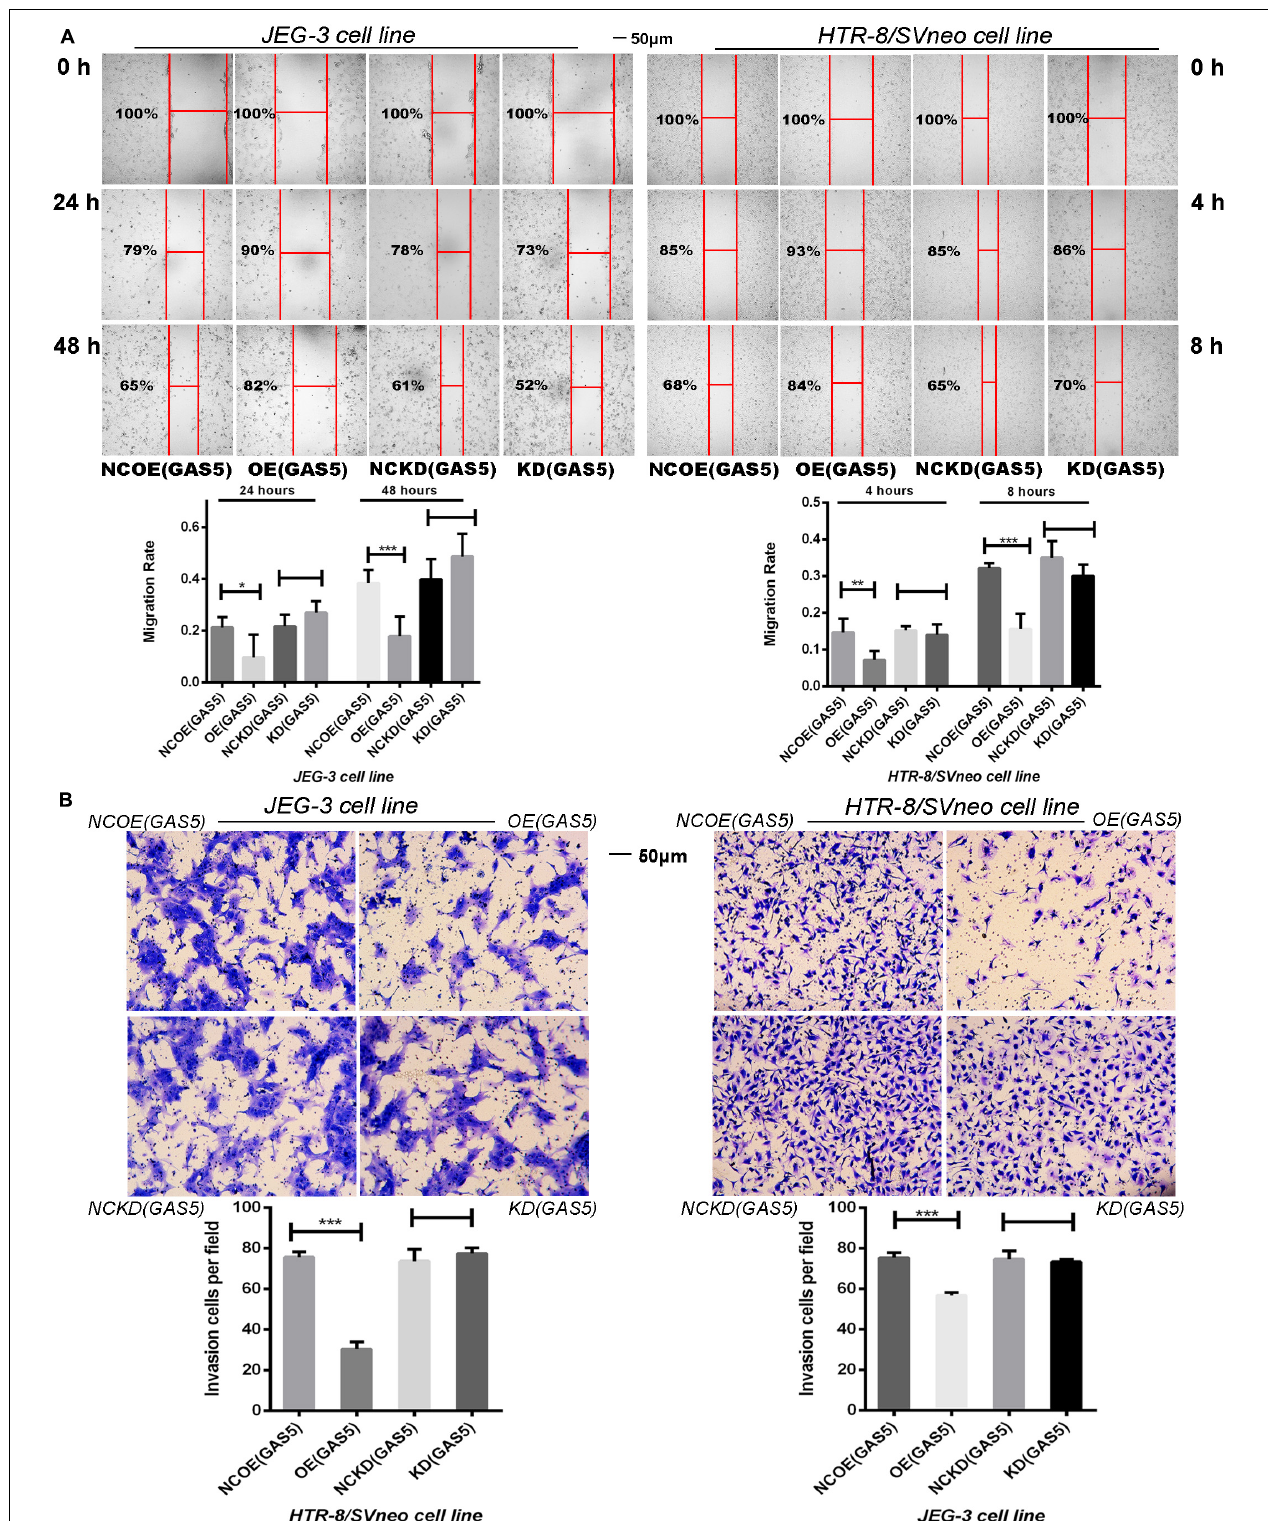
FIGURE 4 | (A) The Scratch test demonstrated the migration ability of two cell lines. Overexpression of GAS5 inhibited the migration of trophoblasts while knockdown GAS5 didn’t alter their migration ability. (B) Overexpression of GAS5 inhibited the invasion ability of trophoblasts according to transwell assay results, in the meanwhile, knockdown GAS5 didn’t alter their invation ability. * P < 0.05, ** P < 0.01, *** P < 0.001.